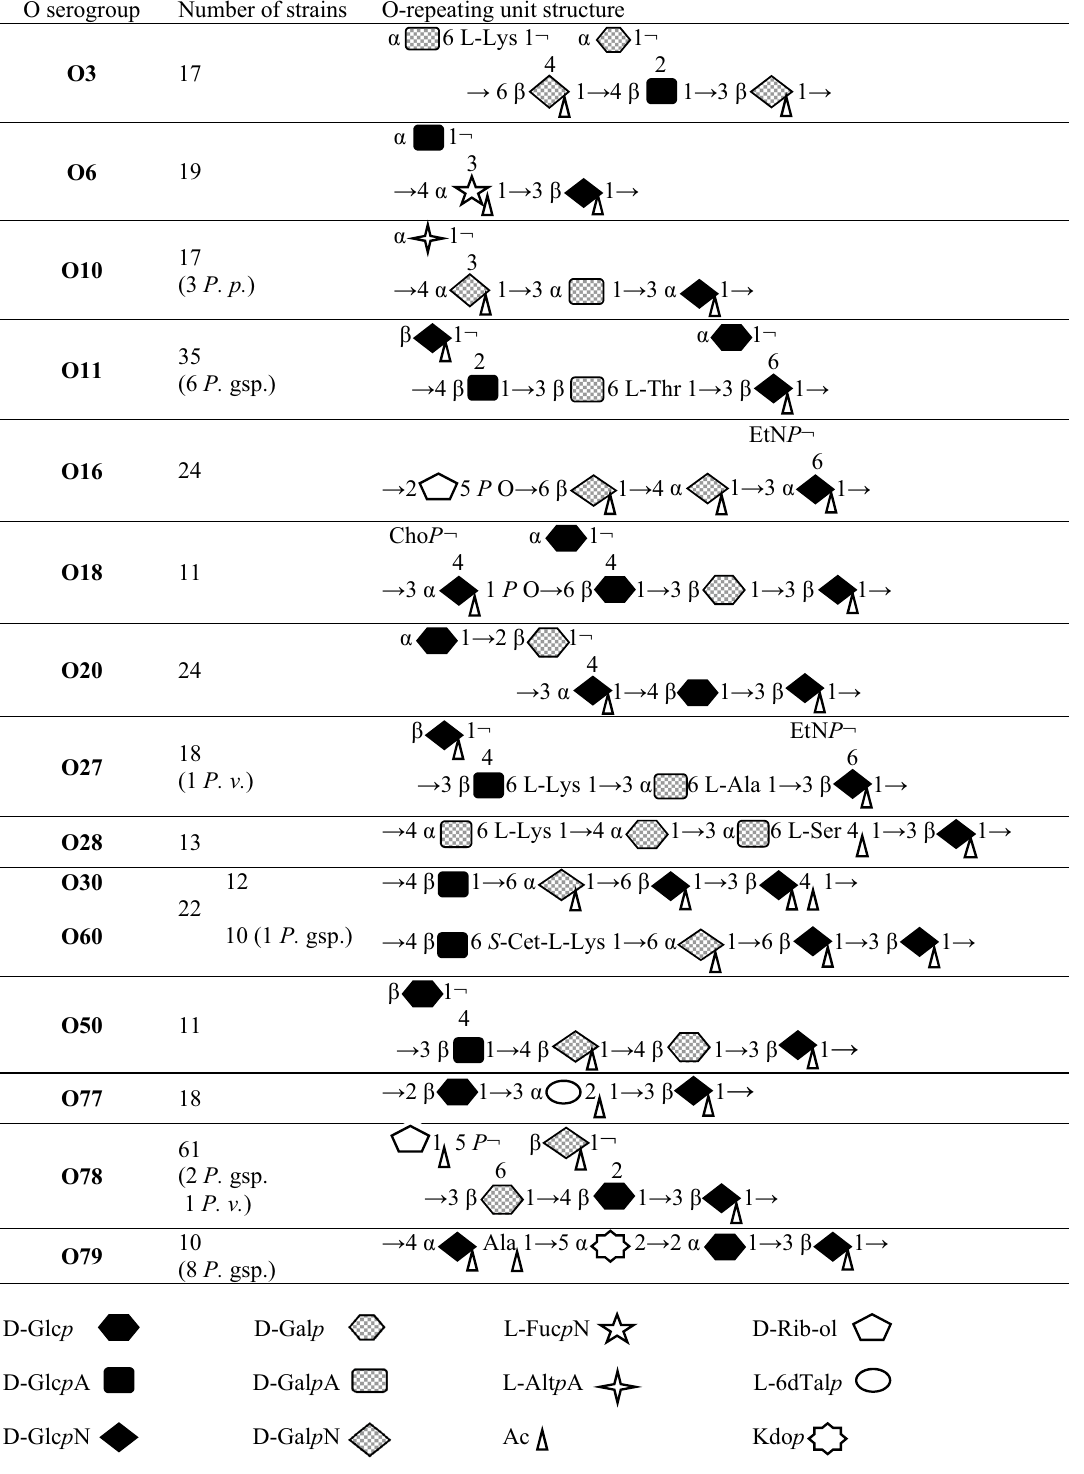
Table 3. The O repeating unit chemical structures 7,15 of the most prevalent Proteus spp. O serotypes in central Poland. The total number of strains includes non- P. mirabilis strains number (in parenthesis). Sugar components and acetyl groups are imagined as